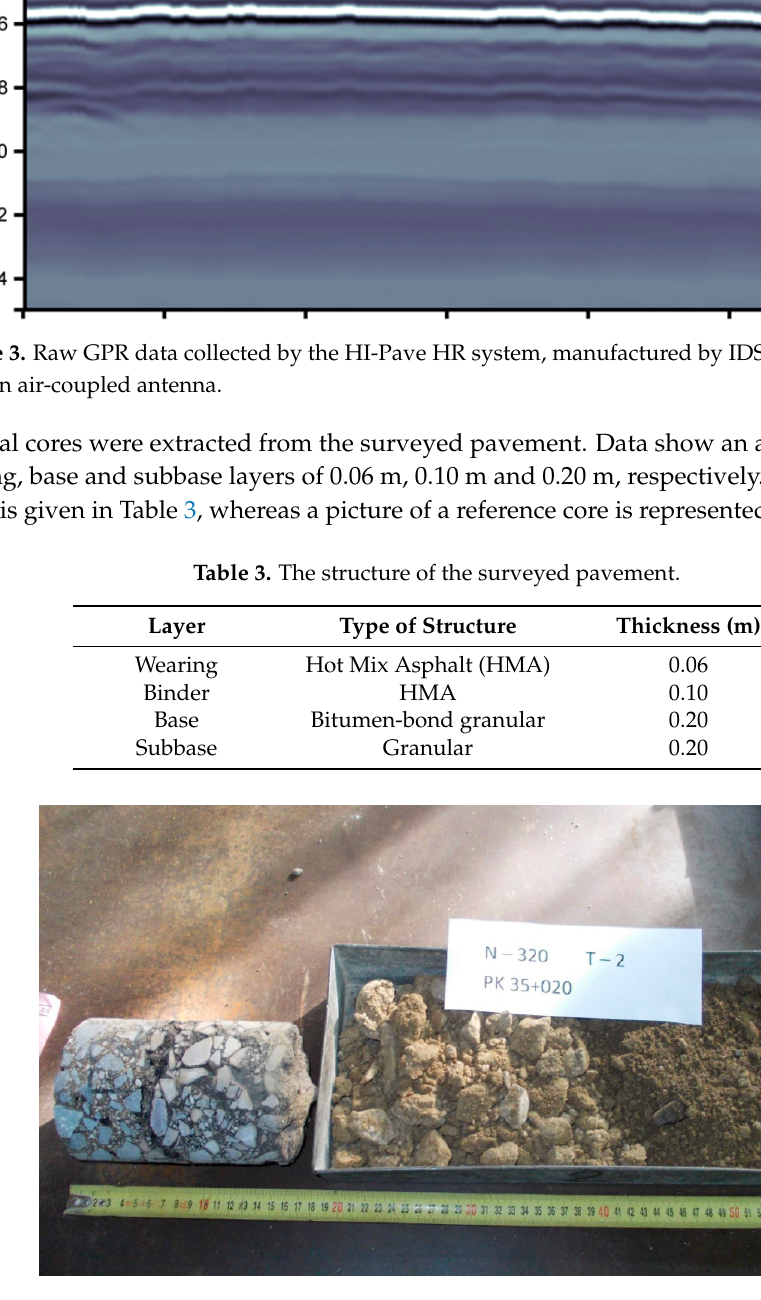
Figure 4. Pavement structure by a reference sampling core.